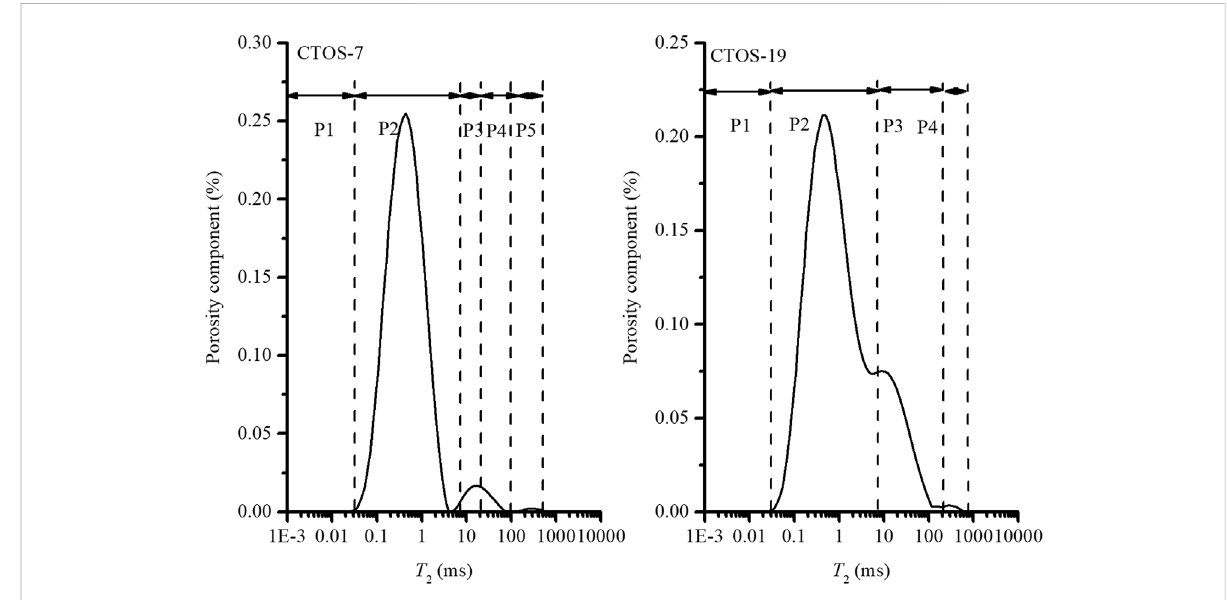
FIGURE 7 The various types of pores in CTOS-7 and CTOS-19 samples.